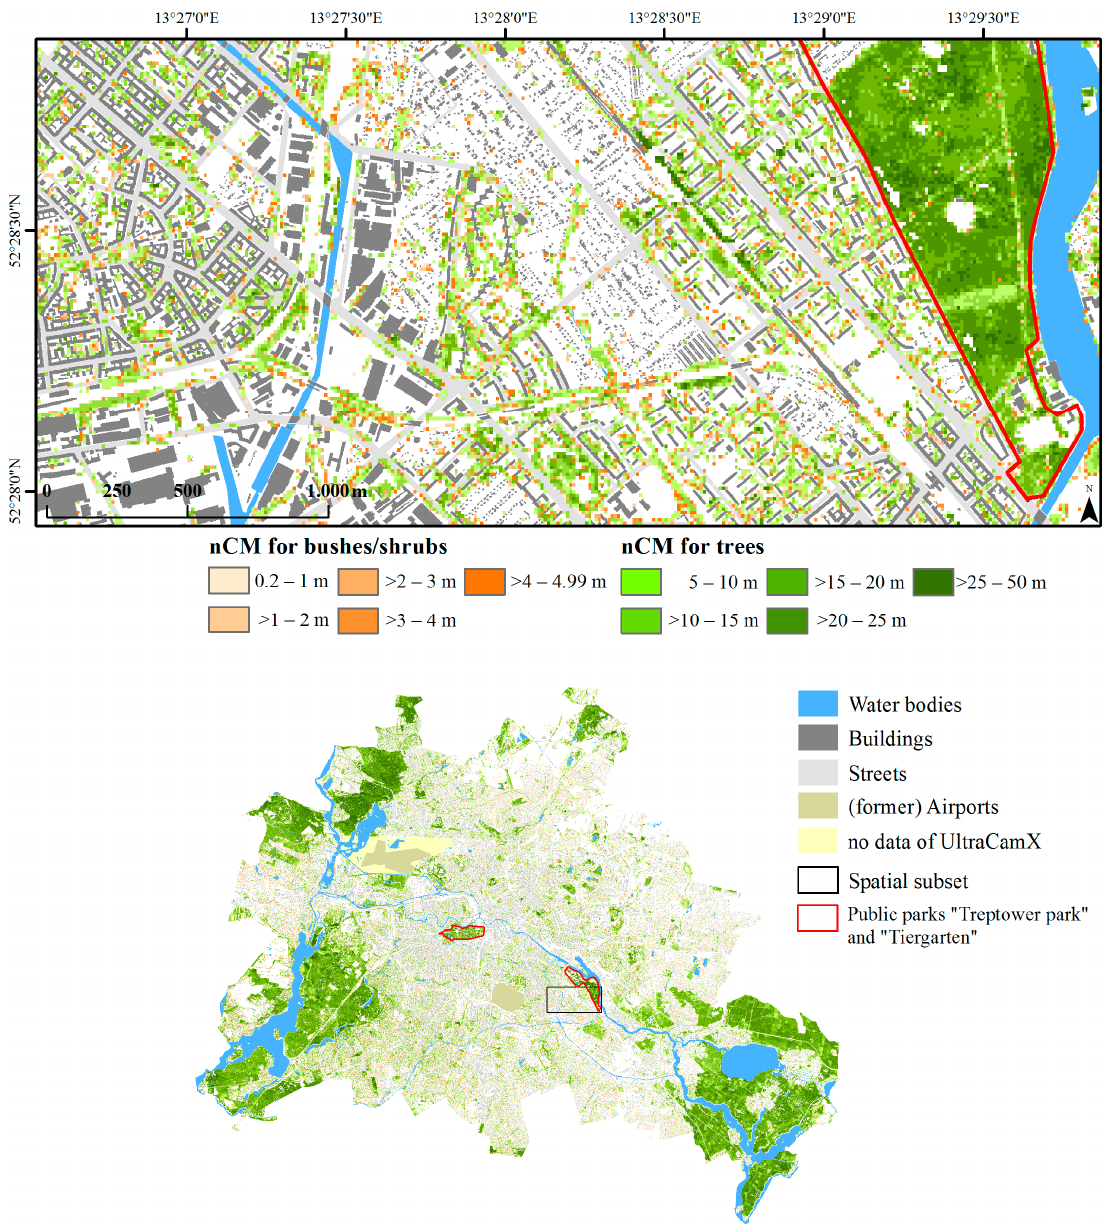
Figure 3. Classified CHMs for bushes and shrubs ( light green ) and trees ( dark green ) for all of Berlin, and a subset in the district Treptow-Köpenick. The included water bodies are derived from the biotope map; the buildings are extracted from an officially available building layer derived from the UltraCamX matrix camera during the same flight campaign as the vegetation assessment [60,61].